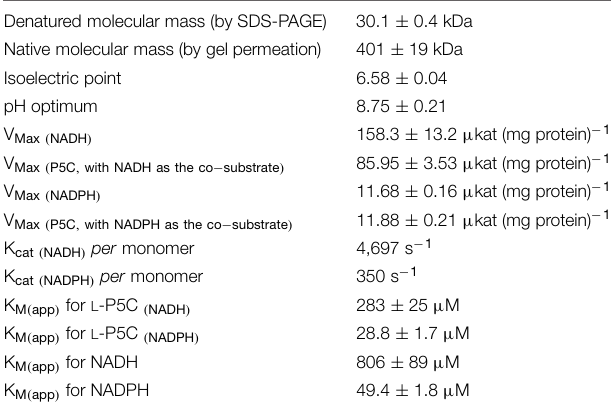
TABLE 2 | Properties of rice P5C reductase.